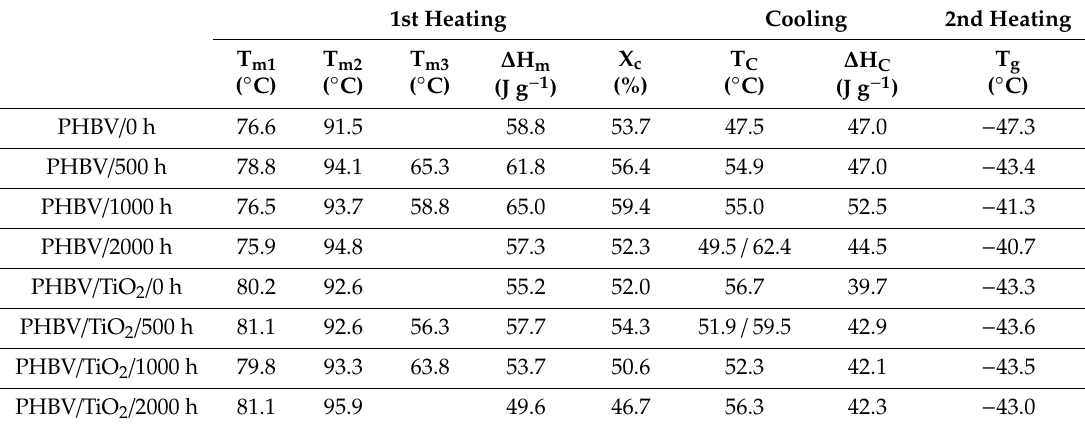
Table 2. DSC data obtained for the neat PHBV and the PHBV / TiO 2 nanocomposites after accelerated weathering degradation. 1st Heating